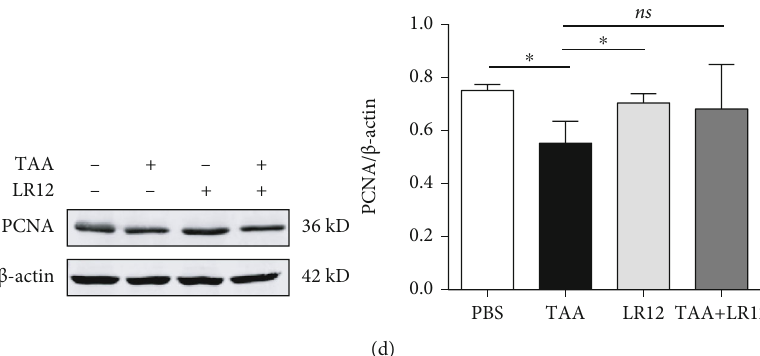
Figure 2: TAA induced hepatic injury in vitro and LR12 did not directly promote the proliferation of hepatocytes. (a) Western blot analysis of PCNA in LO2 cells stimulated with di ff erent concentrations of TAA (0.5, 1, and 2 mM). (b) CCK-8 assay of viability of LO2 cells. (c) CLSM showing CK18 and PCNA staining in LO2 cells. (d) Western blot analysis of PCNA expression in LO2 cells stimulated with TAA (1 mM) and/or LR12 (10 ng/mL). Data were presented as the mean ± standard deviation (SD). ∗ P < 0 : 05 , ∗∗ P < 0 : 01 , and ∗∗∗ P < 0 : 001 versus control